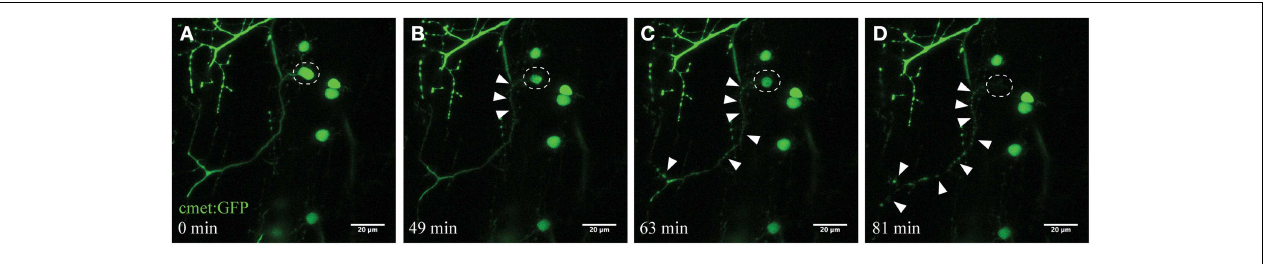
FIGURE 2 | Time-course imaging of the neurodegeneration of UV-ablated spinal neurons. (A–D) UV-irradiation of a single spinal neuron ( cmet : GFP ; A ; circle) resulted in the soma of the neuron shrinking over time, followed by axonal fragmentation ( B ; arrowheads). This axonal degeneration